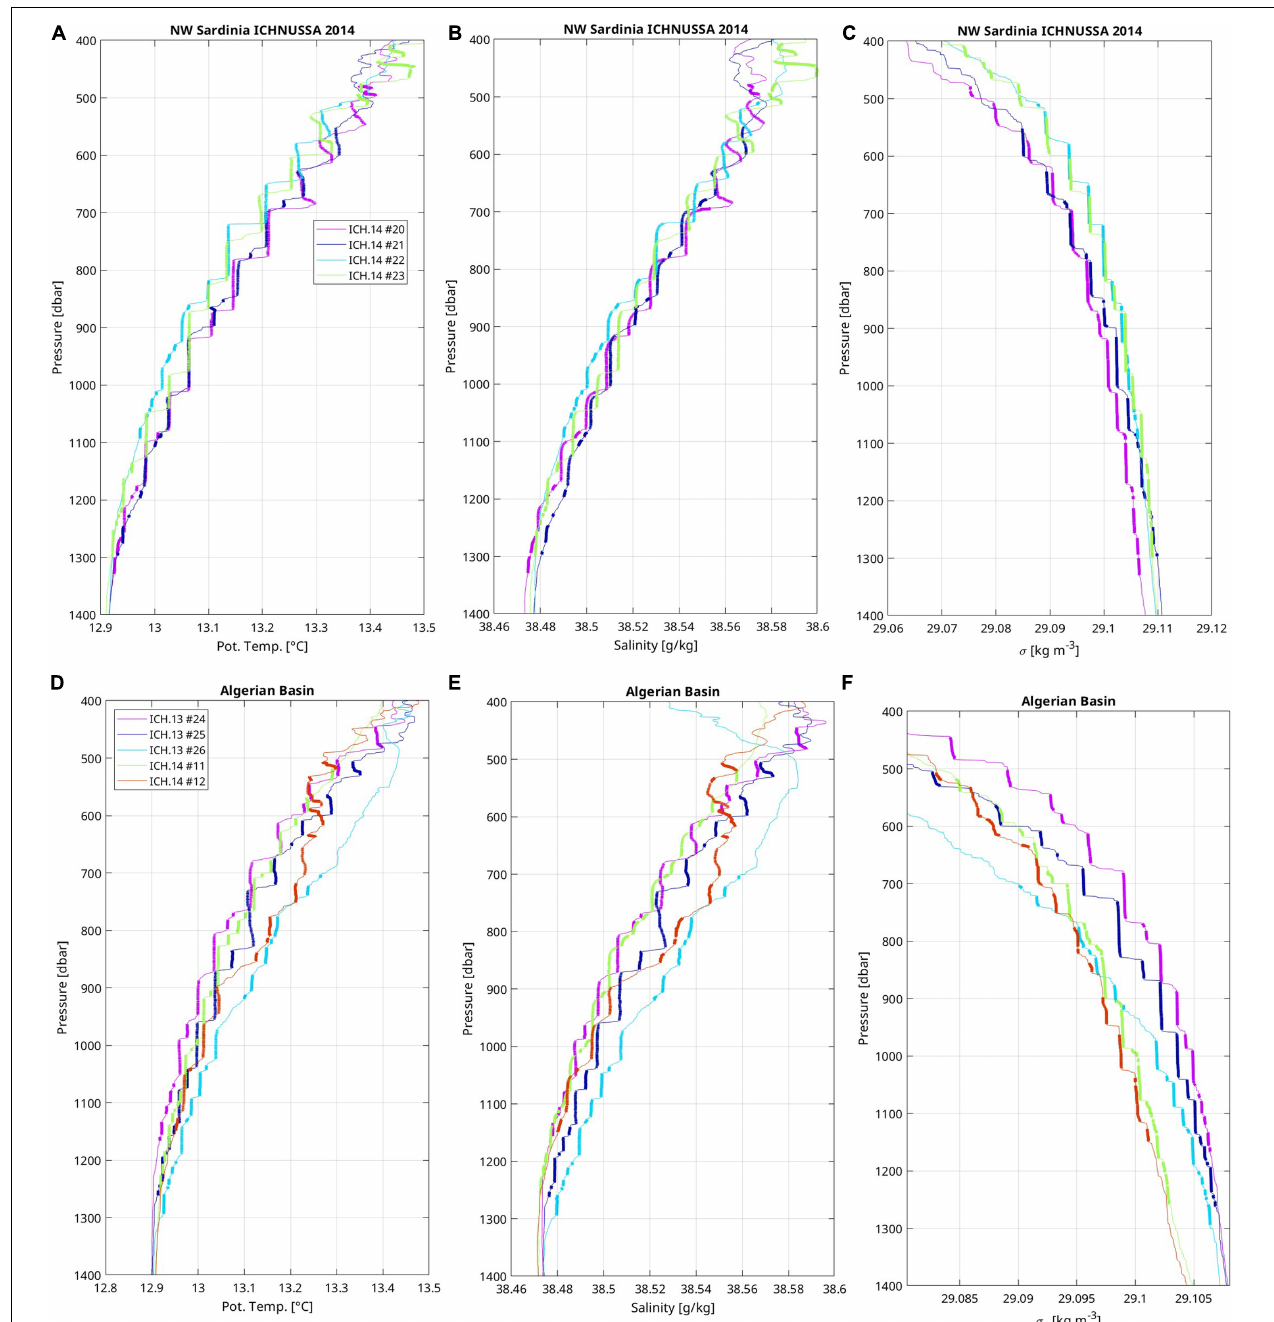
FIGURE 3 | Vertical profiles in staircases of (A,D) potential temperature, (B,E) salinity, and (C,F) potential density of stations located (A–C) to the north west of Sardinia during ICHNUSSA 2014, and (D–F) in the Algerian sea during ICHNUSSA 2013 and 2014 fall cruises. Station numbers are indicated in the figure legend (A,D) and located on the map ( Figure 1 ). Layers are emphasized by thick lines with weak vertical gradient